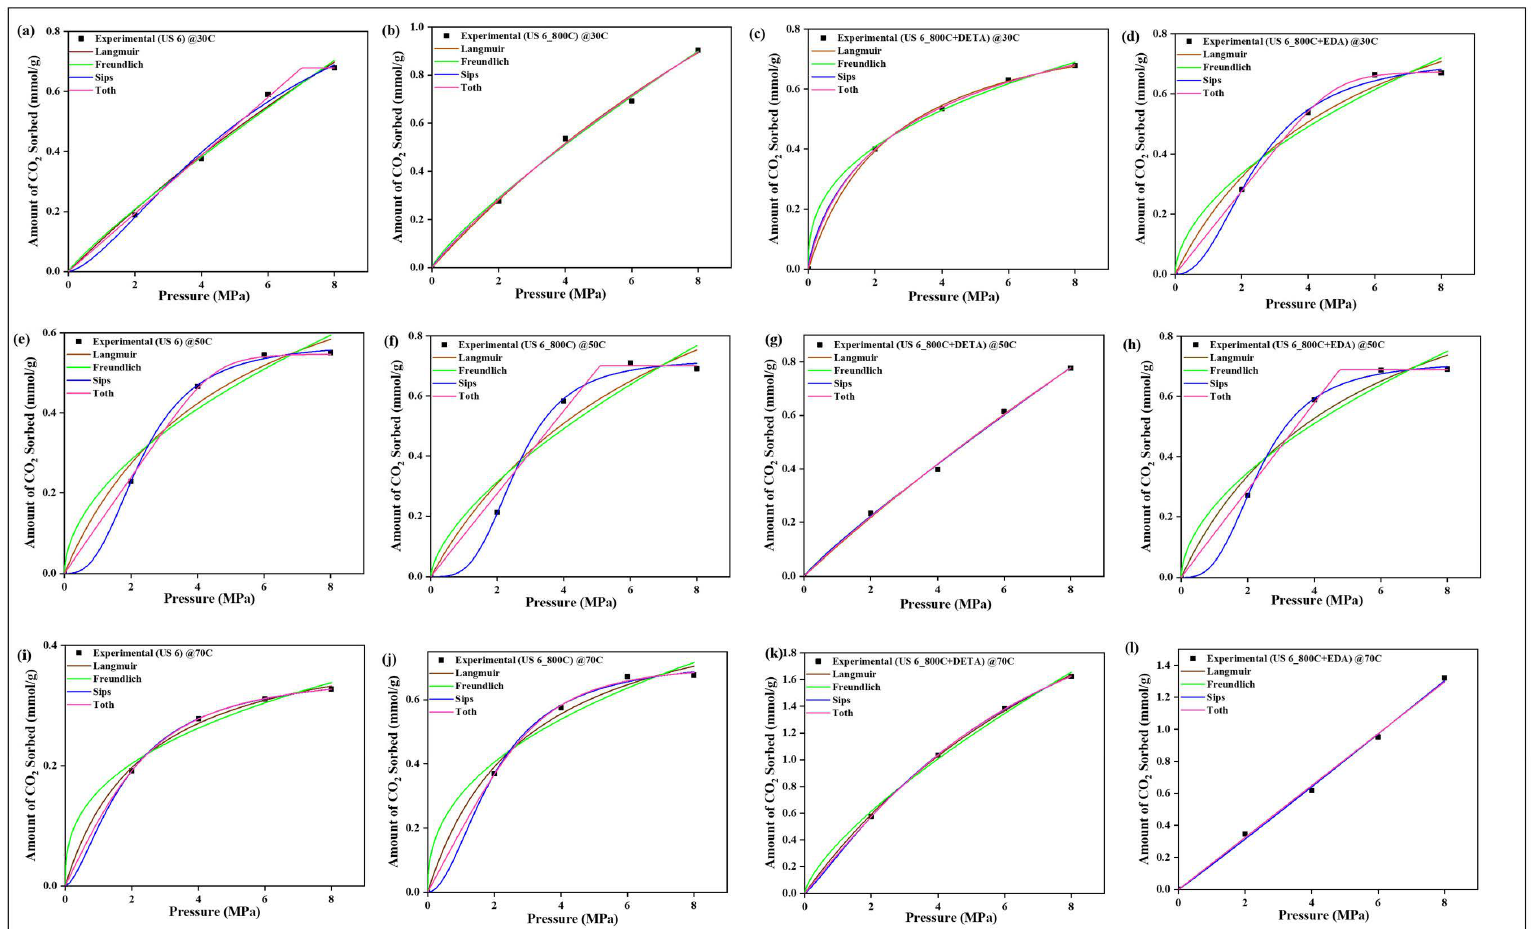
Figure 13. Prediction of the sorption behavior of US 6 variants with Isotherm models at temperatures 30 ◦ C ( a – d ), 50 ◦ C ( e – h ), 70 ◦ C ( i – l ), and up to 8 MPa